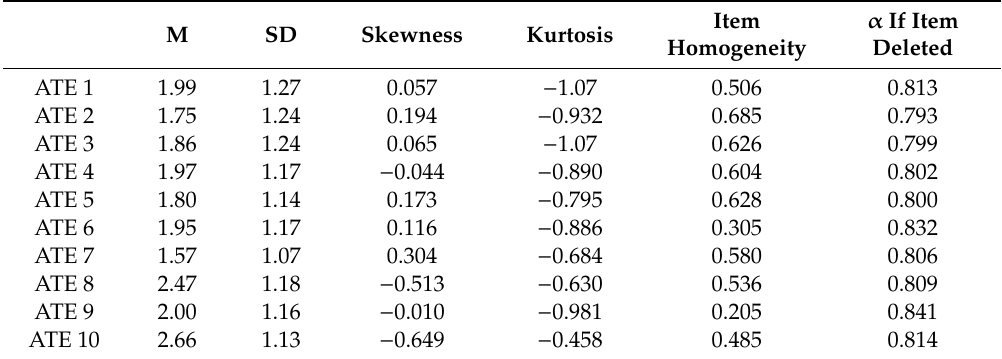
Table 1. Means, standard deviations, item homogeneity and α if item deleted for the ten items of the Attitude Toward Euthanasia Scale. M SD Skewness Kurtosis